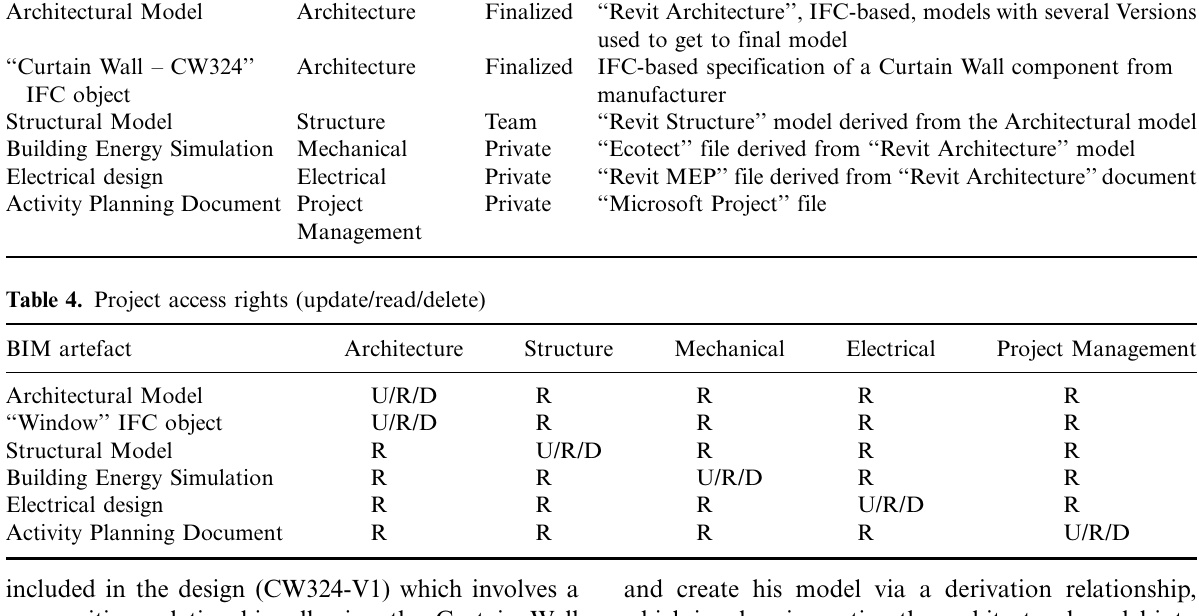
Table 3. Project BIM artefacts BIM artefact